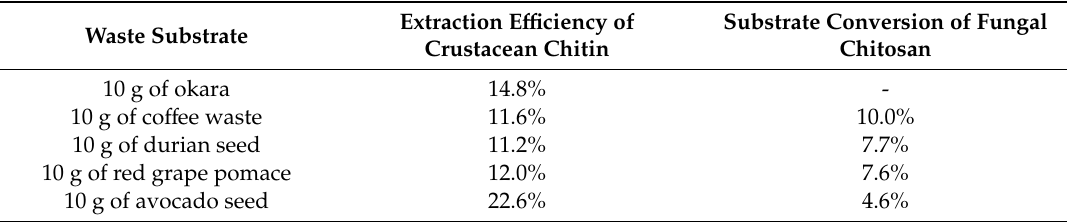
Table 6. Extraction e ffi ciency of crustacean chitin from prawn shell waste and the substrate conversion e ffi ciency for growth of fungal